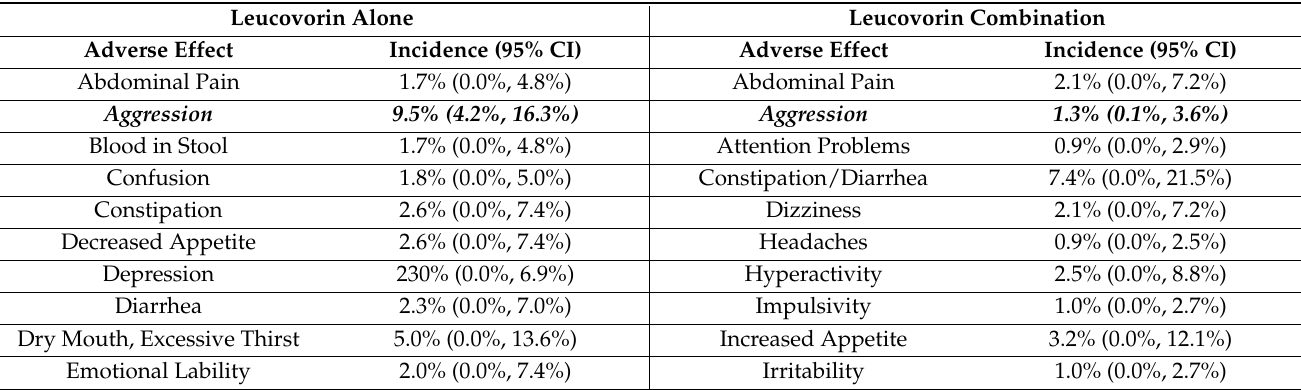
Table 5. Meta-analysis of Adverse Effects Associated with Leucovorin in Children with ASD. Bold and italics indicate significant effects across